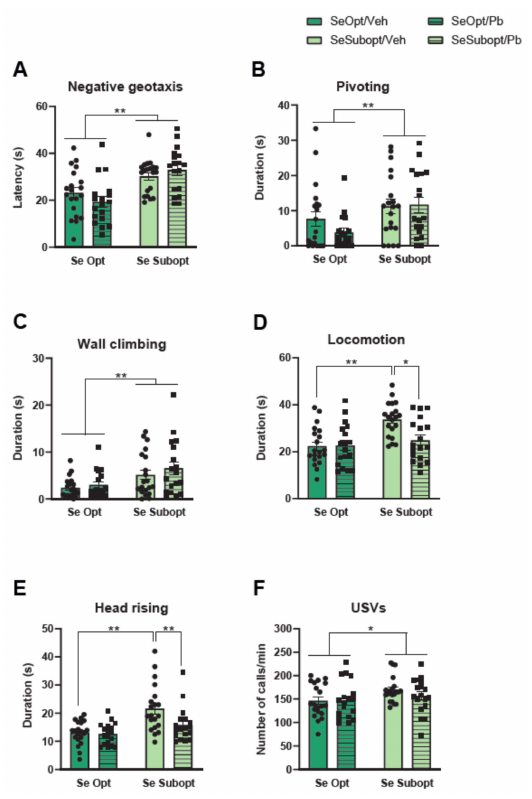
Figure 2. Neonatal assessment in pups at post-natal day (PND) 4, 7, 10, and 12. ( A ) Mean latency to perform negative geotaxis (values pooled across PND 4–12); ( B ) pivoting duration at PND 10; ( C ) total duration of wall climbing, ( D ) locomotion, and ( E ) head rising (values pooled across PND 4–12); ( F ) mean number of USVs emission (values pooled across pnd 4–12). Data are shown as individual value plots and are sex-pooled represented; * p < 0.05, ** p < 0.01.